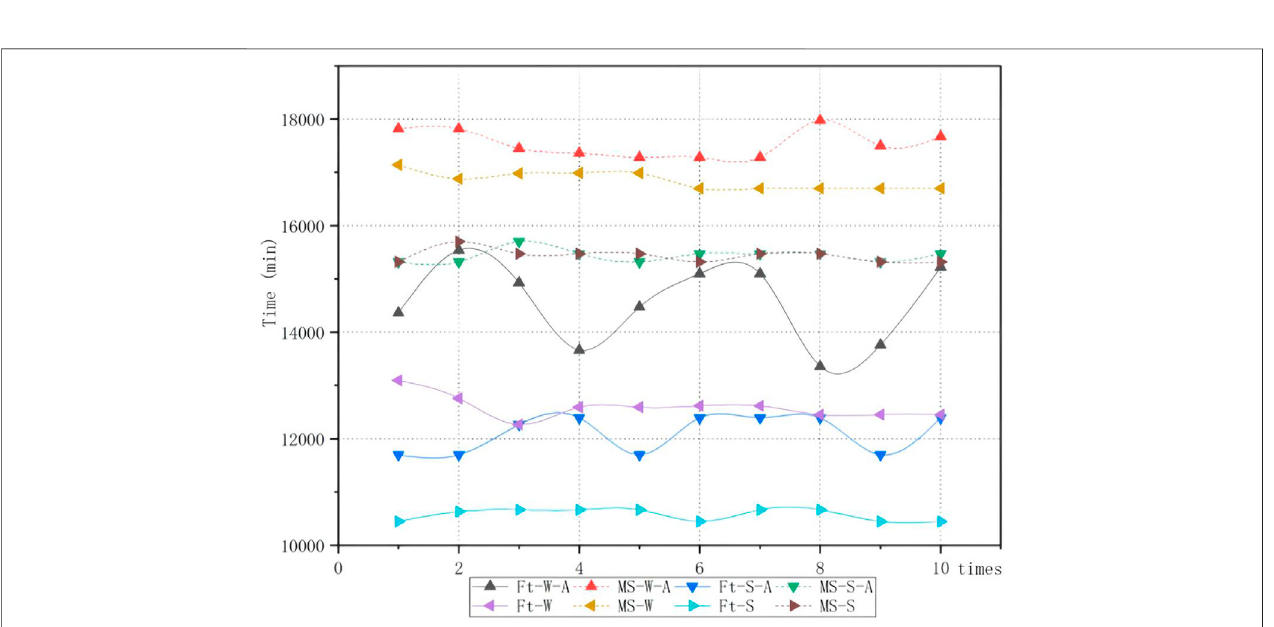
FIGURE 11 | Comparison of different